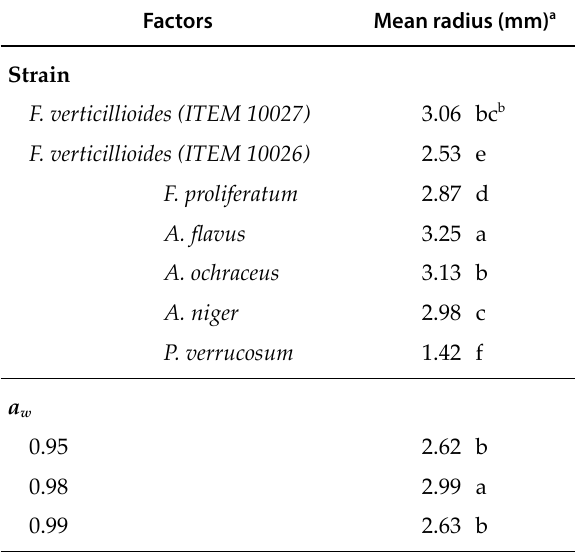
Table 4. Analysis of variance results for growth (mean col- ony radius) at 25°C for the seven fungal strains tested on MA agar at three different levels of a w , from 0.95 to